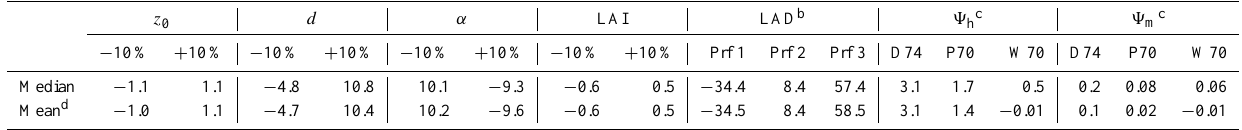
Table 2. Relative difference between V d ( O 3 ) determined by the modified gradient method with different parameters/formulas (%) a .